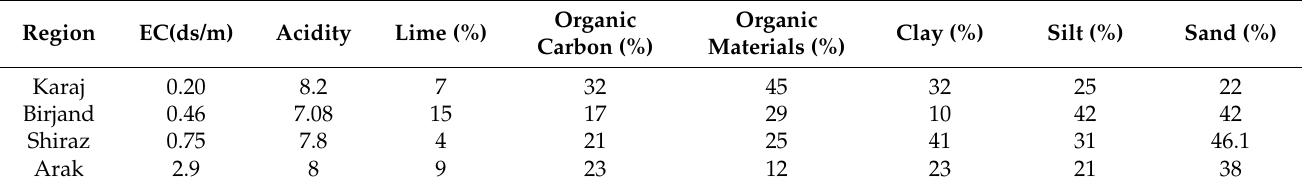
Table 3. Soil specifications of Performed the experiment